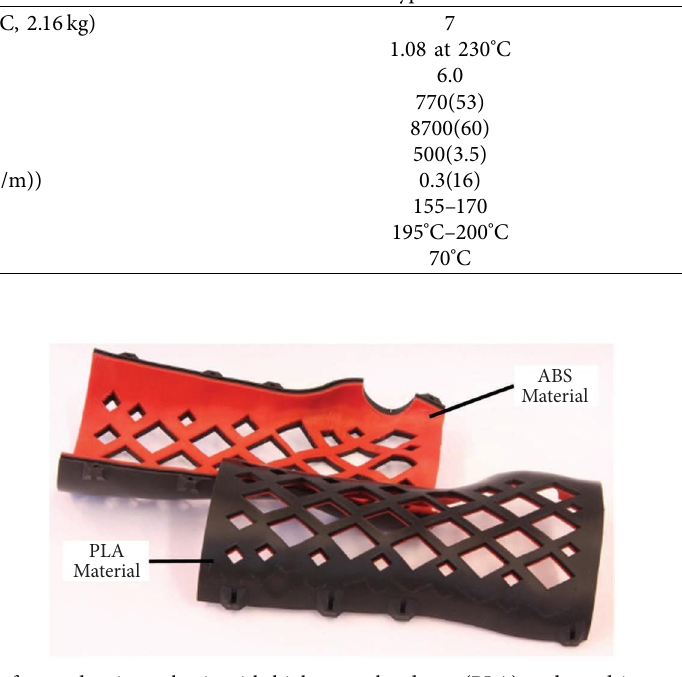
Figure 14: Manufactured wrist orthosis with high outer hardness (PLA) and good inner softness